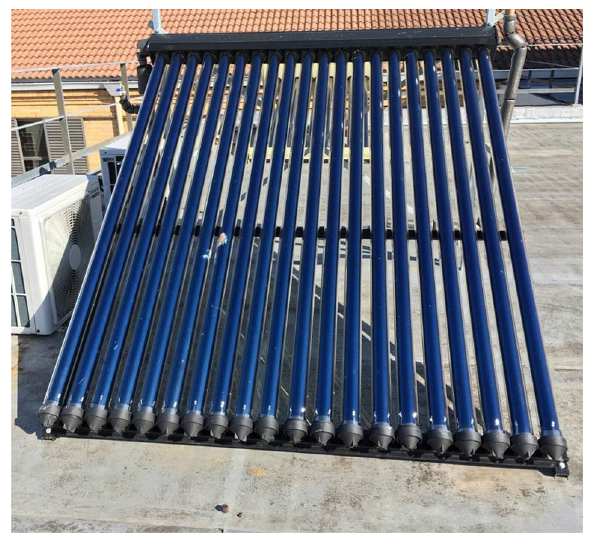
Fig. 3 The 20 evacuated tubed collector unit installed onto the roof